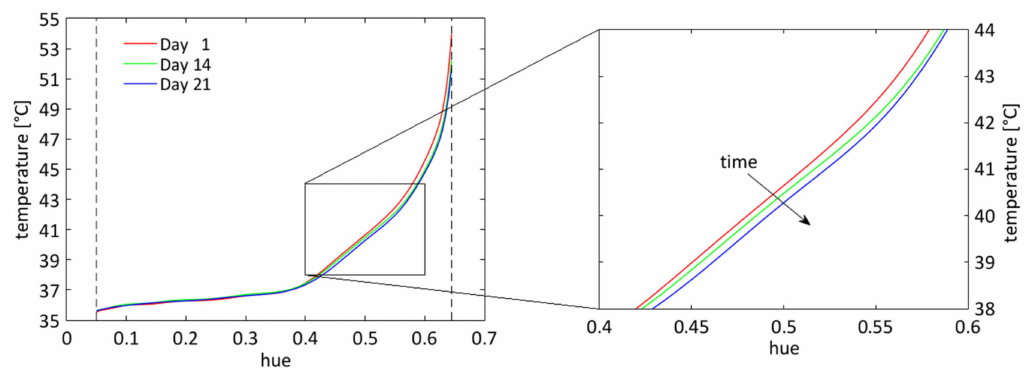
Figure 9. Hue–temperature calibration curves of R35C7W over